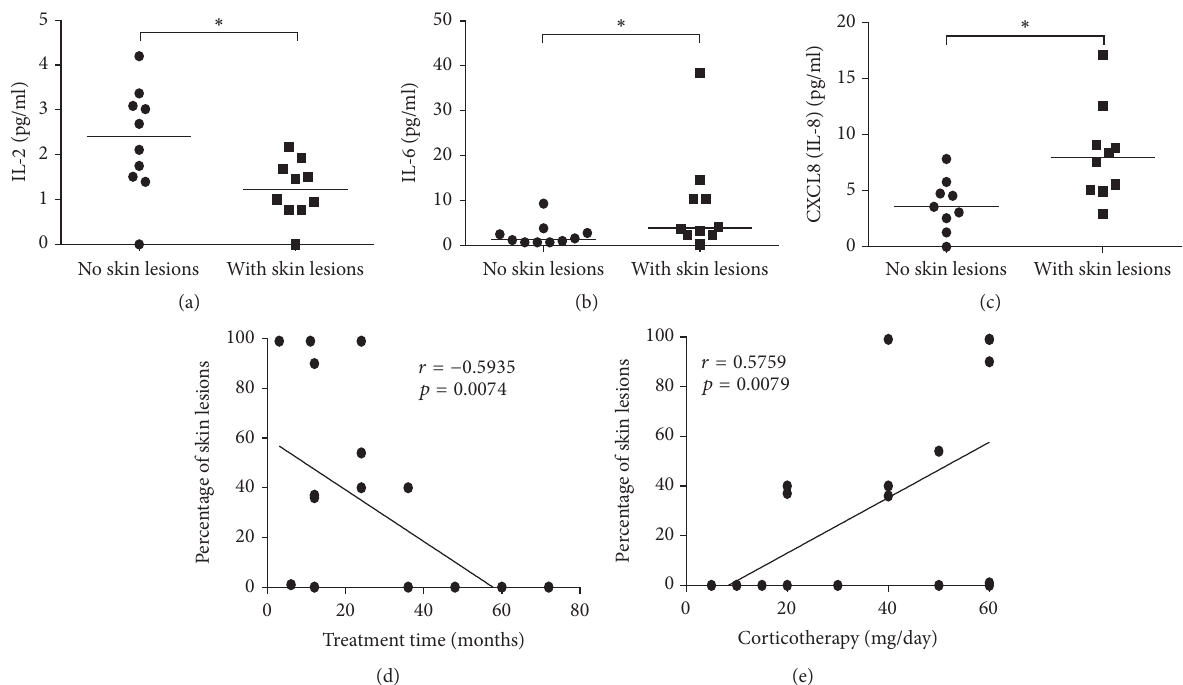
Figure 4: Skin lesions in Pemphigus vulgaris are associated with higher levels of IL-6 and CXCL8. Levels of (a) IL-2, (b) IL-6, and (c) CXL8 (IL-8) in Pemphigus vulgaris (PV) patients with no skin lesions ( (cid:2) ) and PV patients with skin lesions ( ◼ ). (d) Correlation between the frequency of lesions and time of treatment and (e) correlation between the frequency of skin lesions and dosage of glucocorticoids used to treat PV patients. Error bars represent median ± SD. ∗ 𝑝 < 0.05 , Mann–Whitney test was used in (a–c). The Spearman correlation test was used to evaluate the strength of association between the variables (d and